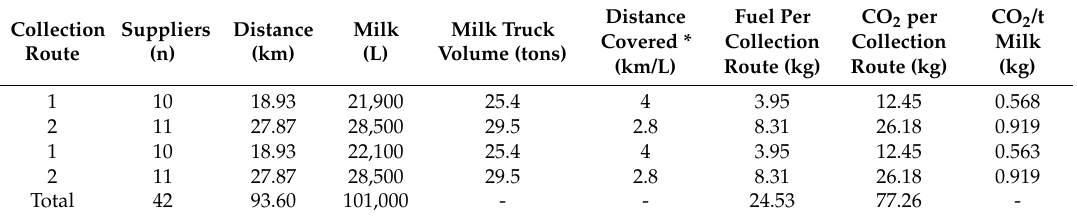
Table 5. Distance (km) and CO 2 emissions (kg) of milk collection routes in the ex-post phase, separation rate 50%, with a simulation of 21 suppliers.